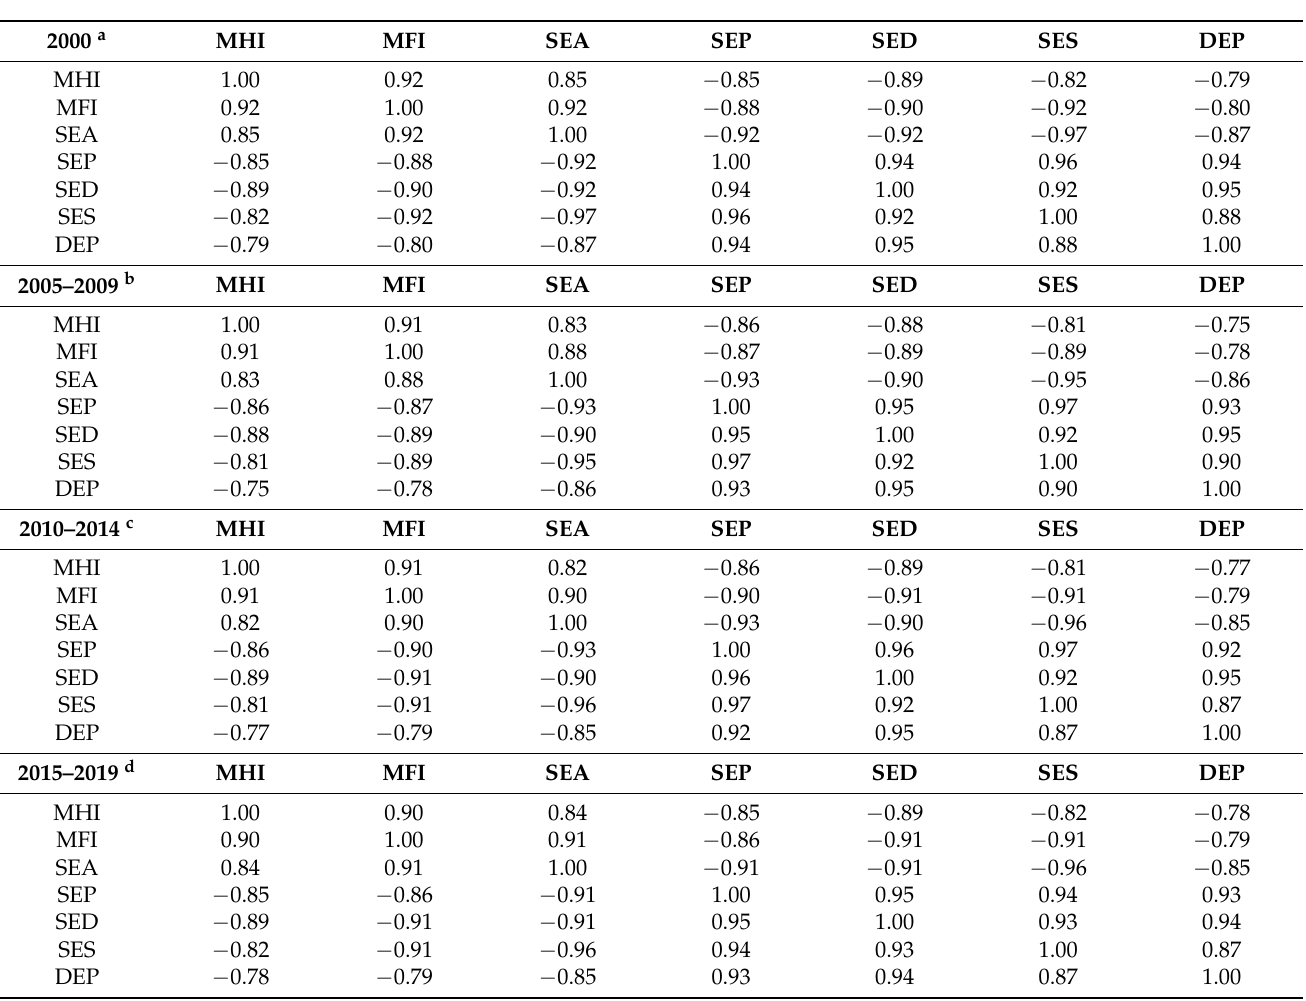
Table 8. Relationships between simple and composite measures of neighborhood socioeconomic status in the Sacramento–Roseville–Folsom Metropolitan Statistical